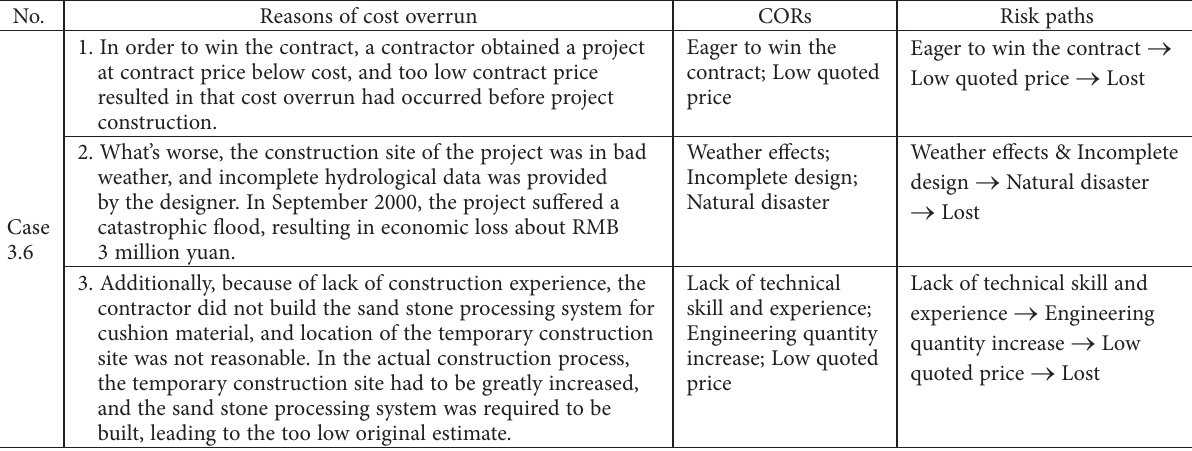
Table 3. Example of identifying CORs and extracting risk paths from Case